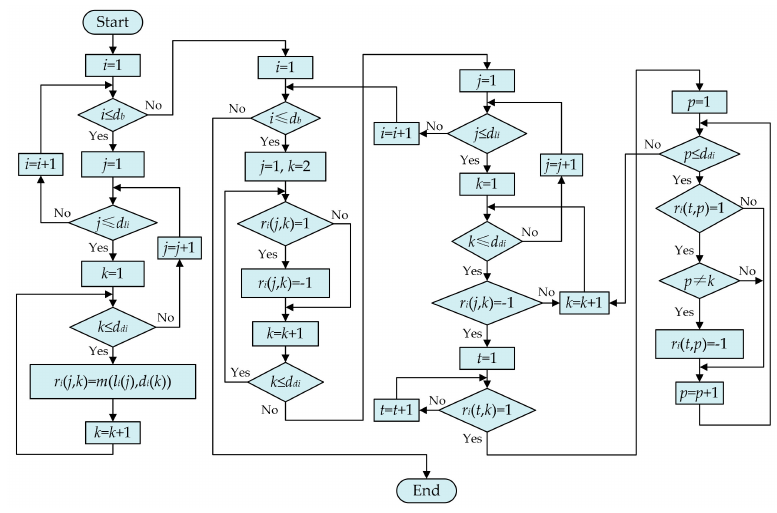
Figure 4. Algorithm to form the matrices of the radial